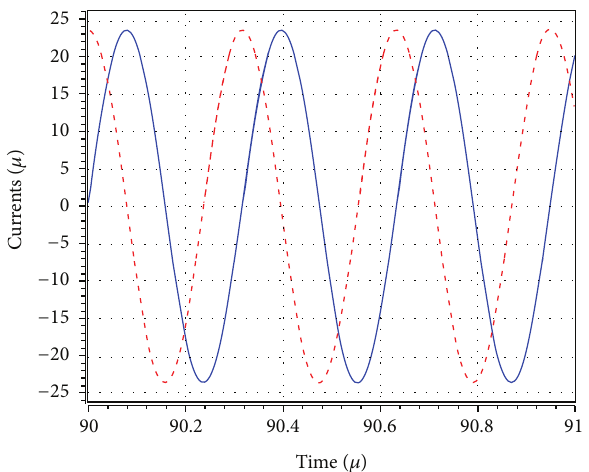
Figure 6: Transient amplitudes of the waveforms of 𝐼 𝑜1 (blue) and 𝐼 𝑜2 (red).